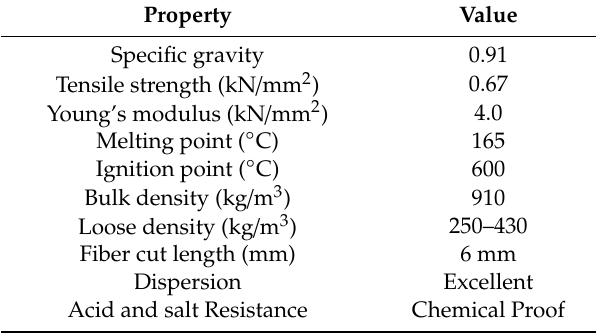
Table 2. Properties of polypropylene fiber